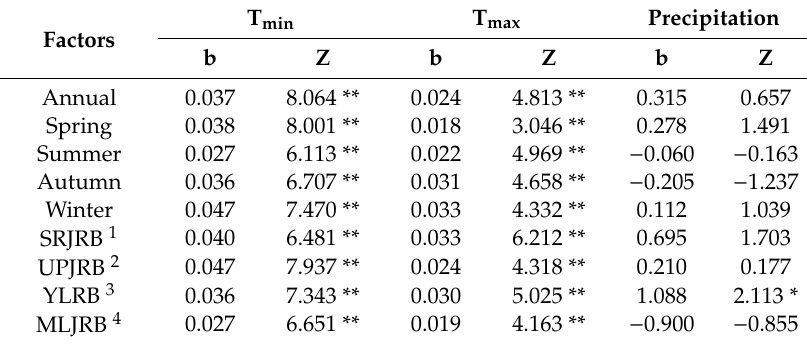
Table 2. Results of Theil–Sen approach (TSA) statistic b and Mann–Kendall (MK) test statistic Z for the minimum / maximum temperature and precipitation time series.